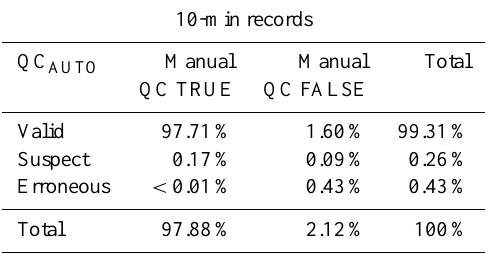
Table 2. Overall performance of the automatic QC. The evalua- tion is performed over the full month of November 2014. A total of 298512 (100%) 10-min records including all soil/grass temper- ature parameters recorded within the RMI AWS network have been